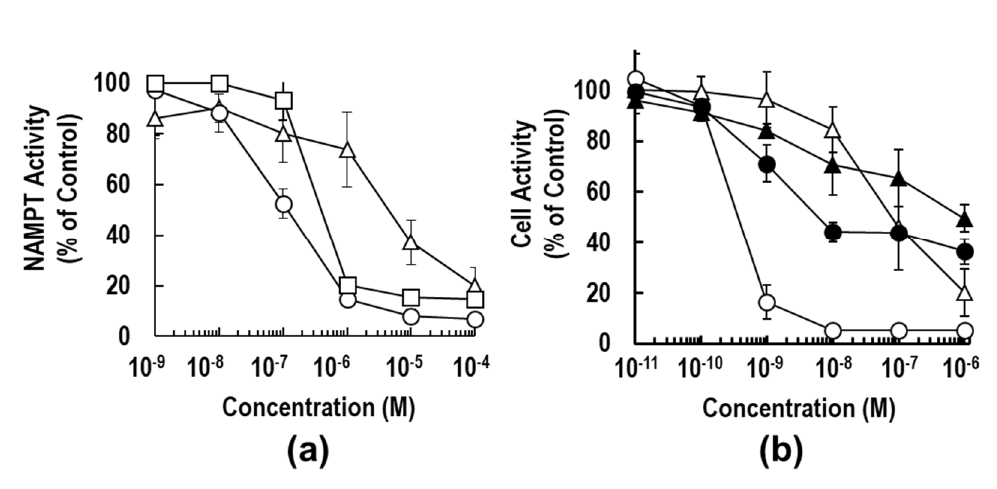
Figure 3. Biochemical properties of 3a and 3b . ( a ) The inhibitory activities of 3a (open circle), 3b (open triangle) and 1 (open square) against NAMPT enzyme were examined, as described previously [31,36,37]. NAMPT activity was measured using a coupled-enzyme reaction system (CycLex NAMPT colorimetric assay kit) in 96-well plate format using the one-step method. Data are the averages of three independent experiments, and the bars indicate the standard error (SE) values. ( b ) The anti-proliferative e ff ects of 3a (circle) and 3b (triangle) on HCT116 cells were investigated as described previously [31,36,37]. HCT116 cells were treated with the indicated concentrations of each inhibitor with (closed symbol) or without (open symbol) 100 µ M NMN for 72 h. The cell activity (% of control) was measured by use of the WST-8 assay. Data are presented as the means of three independent experiments ± SE, and the bars indicate the SE values.